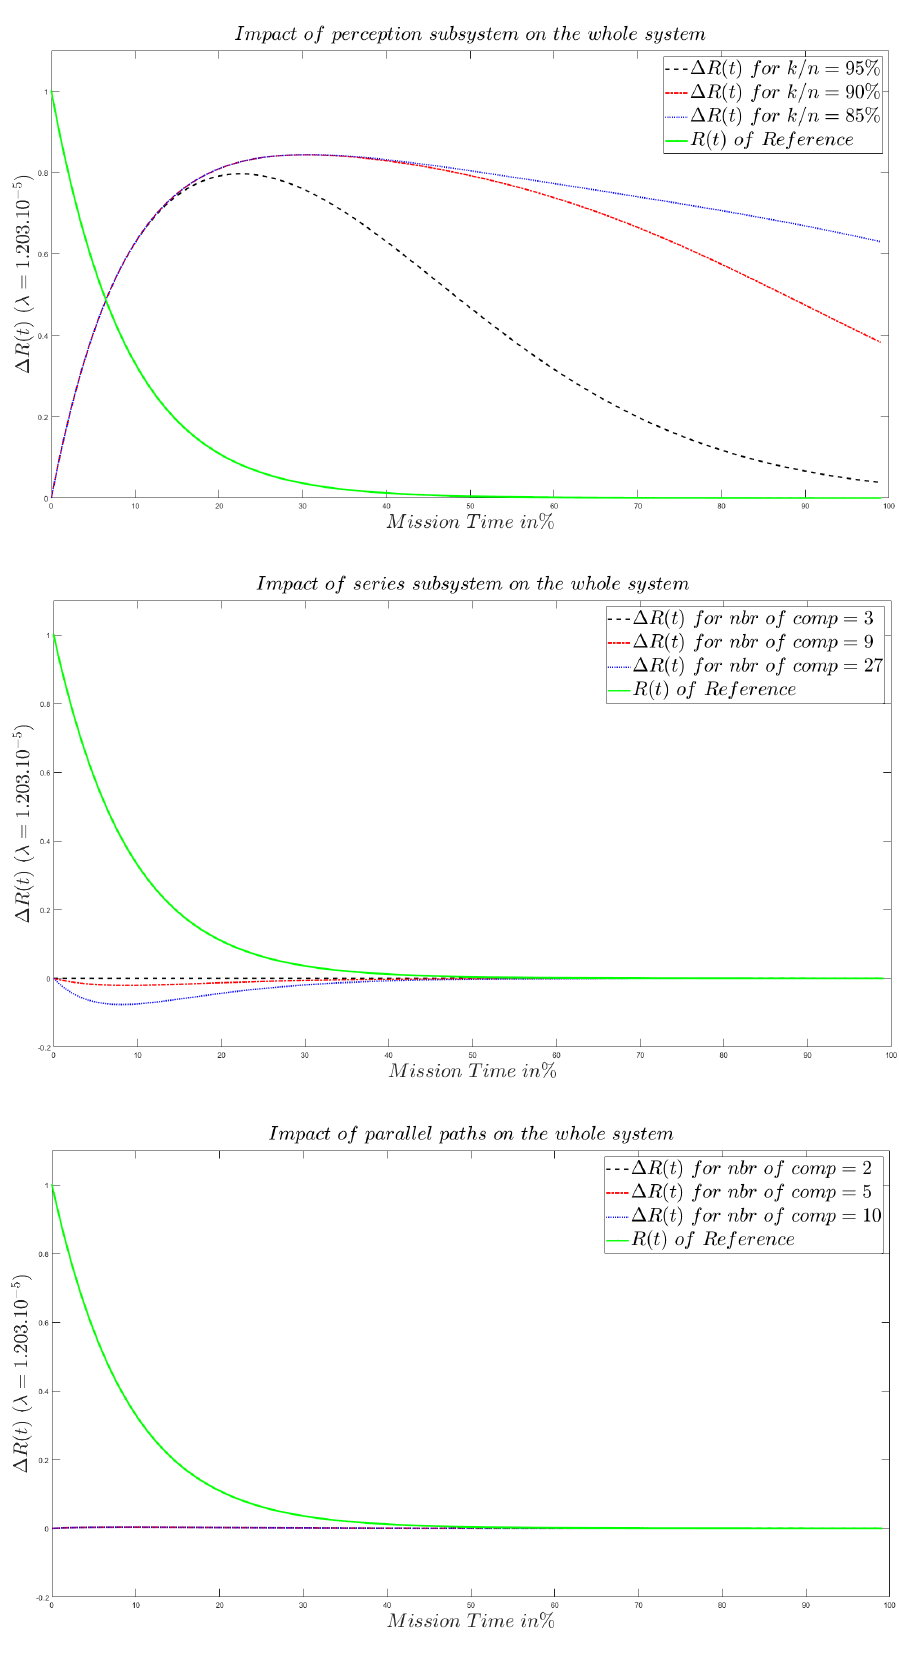
Figure 18. The impact of each structure on the whole system reliability